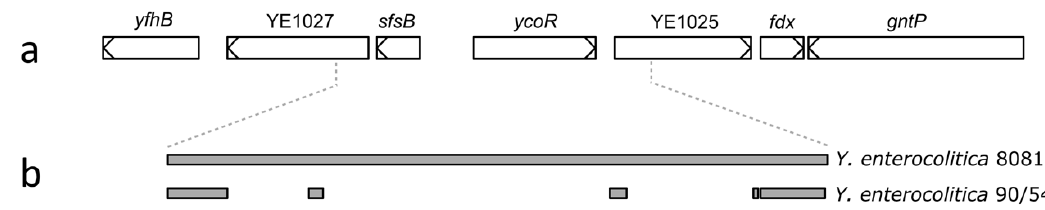
Figure 1. Sequence comparison of the ycoR locus in the Yersinia enterocolitica 8081 and 90/54 strains. In 8081, ycoR lies between YE1027 and YE1025 ( a ), but the region is absent in strain 90/54 ( b ) (areas of significant homology are shaded grey).